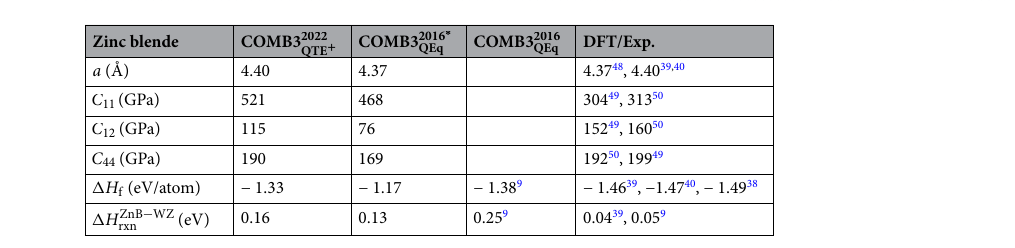
Table 3. Zinc blende AlN properties obtained with COMB3 2022 COMB3 2016 QEq AlN publication, and DFT as well as experimental findings.